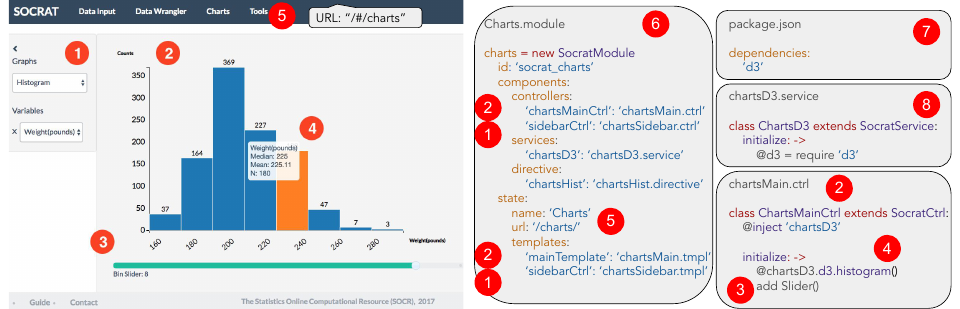
Figure A1. An example of a basic SOCRAT UI-less Database module configuration and initialization: ( 1 ) Core component parses the module list containing a link to the Database module config file; ( 2 ) Core loads module configuration that implements an instance of a SOCRAT module with a unique module identifier; ( 3 ) Core invokes an initialization method of the Database module and passes an instance of the Sandbox component that serves as a proxy to access pub-sub functionality of the Mediator; ( 4 ) Using Sandbox, the Database module passes a list of messages that it can send out or listen to.